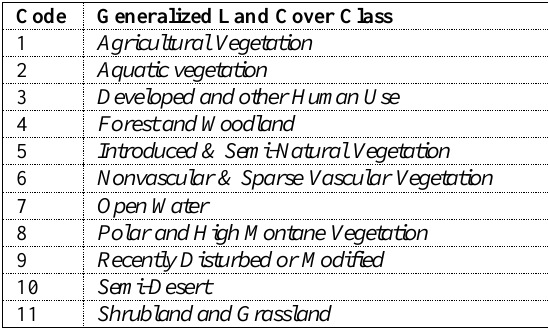
Table 1. List of the 11 General Land Cover Classes used for summarizing the